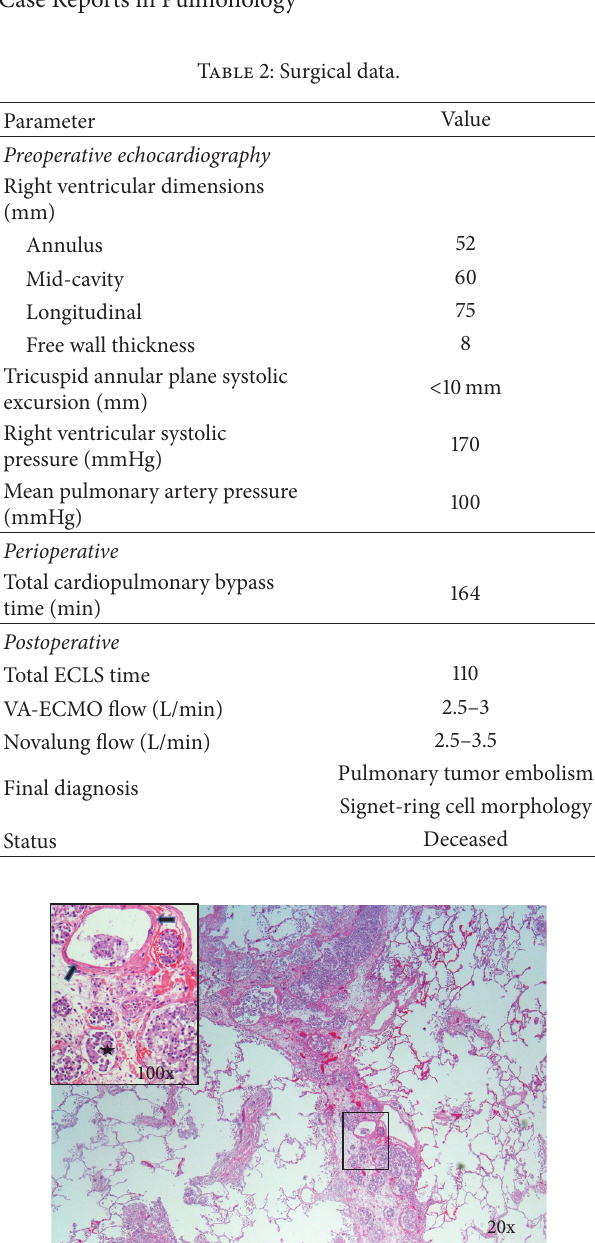
were positive for metastatic adenocarcinoma.